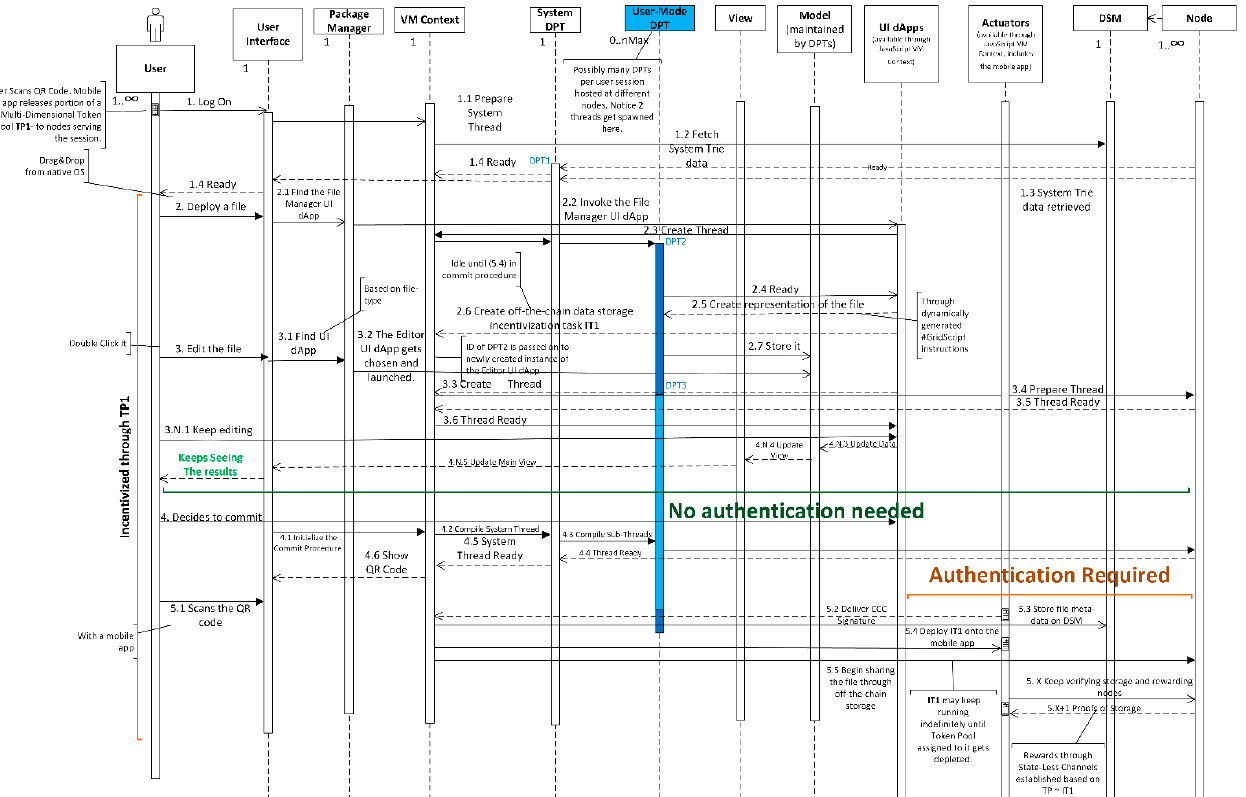
Figure 8 . UML diagram showcasing Deferred Authentication. Figure 8. UML diagram showcasing Deferred